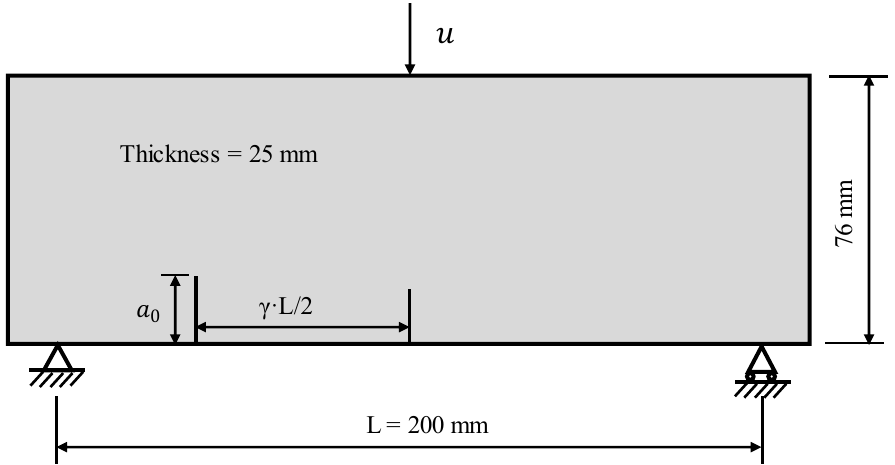
Figure 5. Notched concrete beam: geometry, loading and boundary conditions.